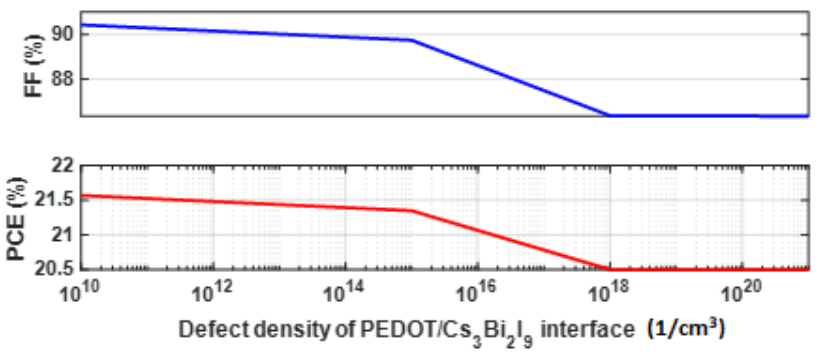
Figure 10. Effect of defect density of PEDOT/Cs 3 Bi 2 I 9 interface on PCE and